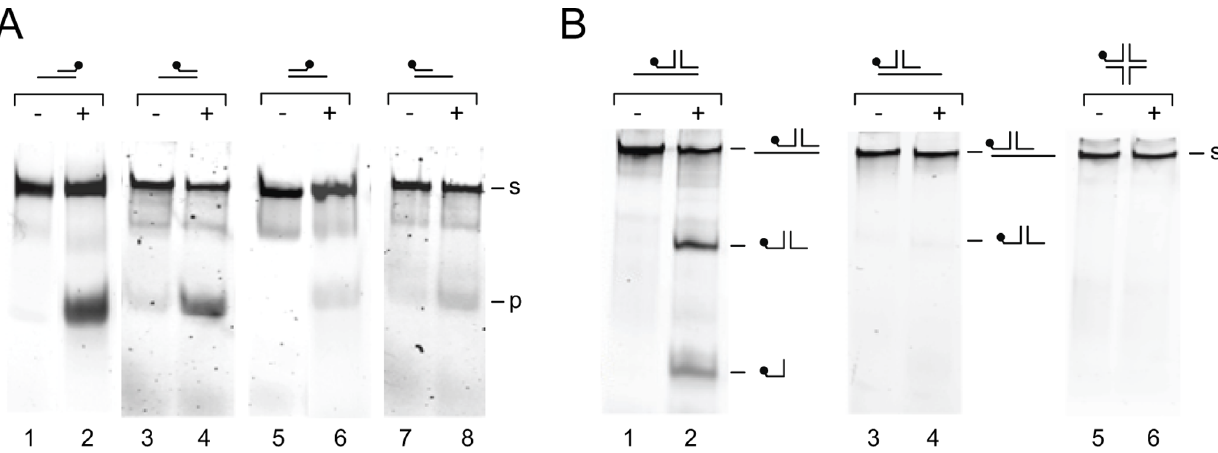
Figure 7. PcrA s FH preferentially unwinds DNA substrates with a 3 9 ss terminus. (A) DNA helicase activity is not significantly influenced by the position of the fluorescent label in the DNA substrate. DNA helicase assays were performed with PcrA s FH and either substrate ‘a’ (6-FAM-labelled at either the 3 9 end [lanes 1 and 2] or 5 9 end [lanes 3 and 4] of strand 1 [Fig. 1]) or substrate ‘b’ (6-FAM-labelled at either the 3 9 end [lanes 5 and 6] or 5 9 end [lanes 7 and 8] of strand 1). The DNA helicase reactions were carried out in volumes of 10 m l and contained DNA substrate (at 8 nM) and either 0 nM (marked ‘ 2 ’, lanes 1, 3, 5 and 7) or 12 nM of protein (‘ + ’, lanes 2, 4, 6 and 8). After the reaction (10 min at 37 u C), the samples were deproteinized, electrophoresed through a native 12% polyacrylamide gel, and analyzed by fluorometry. The positions of the substrates (s) and reaction products (p) are indicated at the right-hand side of the gels. (B) PcrA sFH preferentially unwinds branched DNA substrates that carry a 3 9 ss terminus. The DNA helicase activity of PcrA s FH was tested on branched DNA substrates carrying either a 3 9 ss terminus (substrate ‘d’, lanes 1 and 2), a 5 9 ss terminus (substrate ‘e’, lanes 3 and 4) or blunt ends (substrate ‘f’, lanes 5 and 6). The sequences and structures of the different substrates are shown in Fig. 1. The reactions were performed in a similar fashion as described in (A).